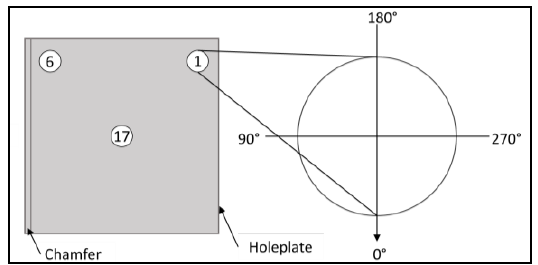
Figure 8: Slope and standard deviation for deviation in unidirectional lengths taken at 1.6 times magnification Figure 5: Orientation of holeplate during imaging and of whole circle bearing The apparent scale error can be corrected using the gradient of the slope, the results can be seen in Figure 9.